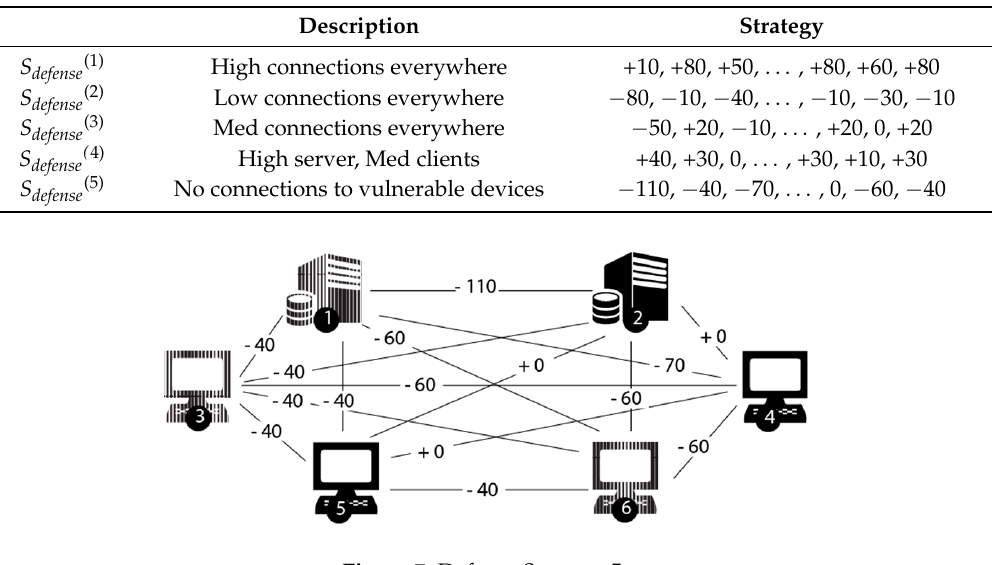
Table 2. Attack strategies.